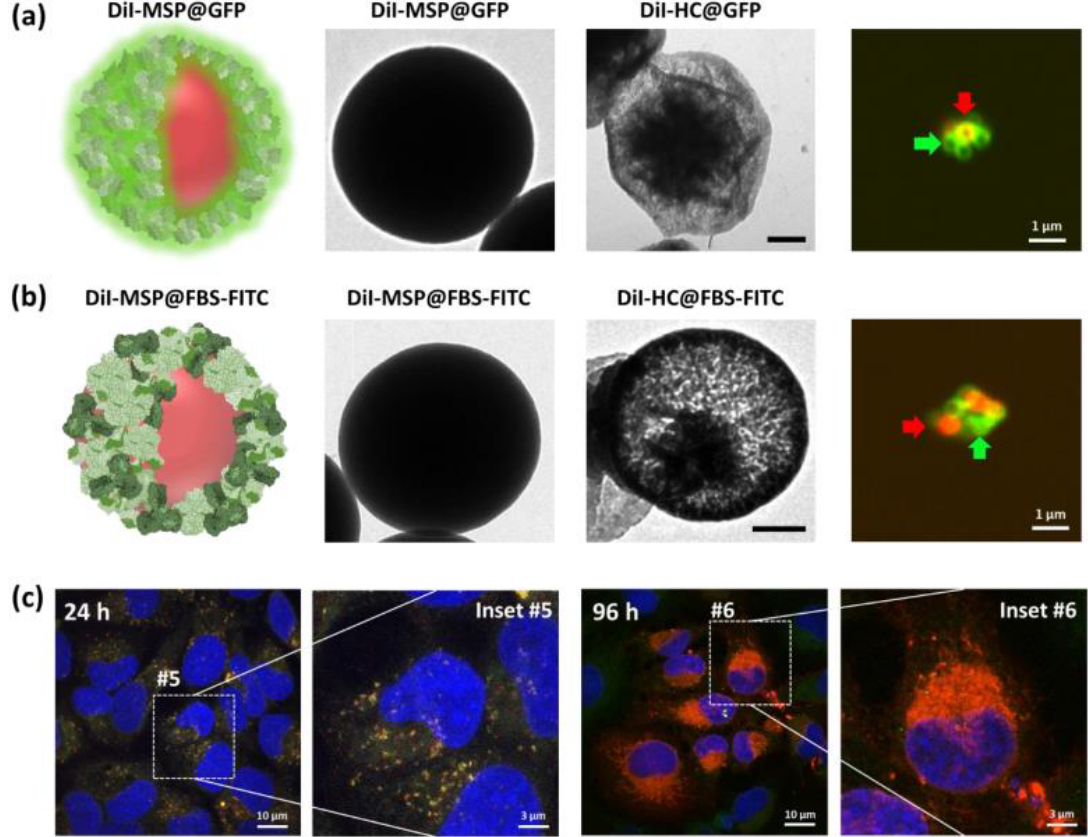
Figure 5. Schematic representation of polymeric protein capsules loaded with DiI. TEM images of DiI-loaded MSP coated with ( a ) purified GFP, or ( b ) FITC-stained serum proteins (FITC-FBS). (right) Single plane confocal images of DiI-HC@GFP and DiI-HC@FBS-FITC. Red arrows point at DiI filled capsules and green arrows to empty shells. ( c ) HeLa cell cultures were treated with DiI-HC@FBS-FITC for 24 (left) and 96 h (right). Internalization of the DiI-MSPs@FBS-FITC capsules is very evident after 24 h. The yellow color of the capsules (yellow = green + red, corresponding to FITC + DiI, respectively) means that systems are still intact inside cells. After 96 h incubation, the red color in the endoplasmic reticulum of most cells suggests dye bust release. Nuclei are stained with Hoechst (blue channel). Insets #5 and #6 shown high magnification of individual cells containing the DiI-loaded capsules. Scale bars on TEM images correspond to 100 nm.